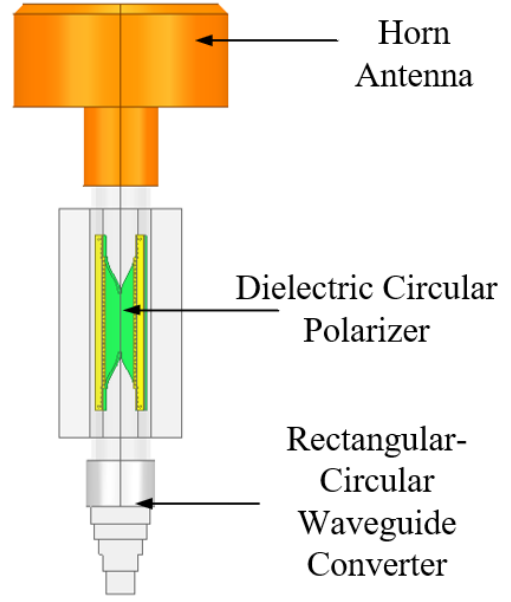
Figure 1. The overall structure of the proposed polarized horn antenna.